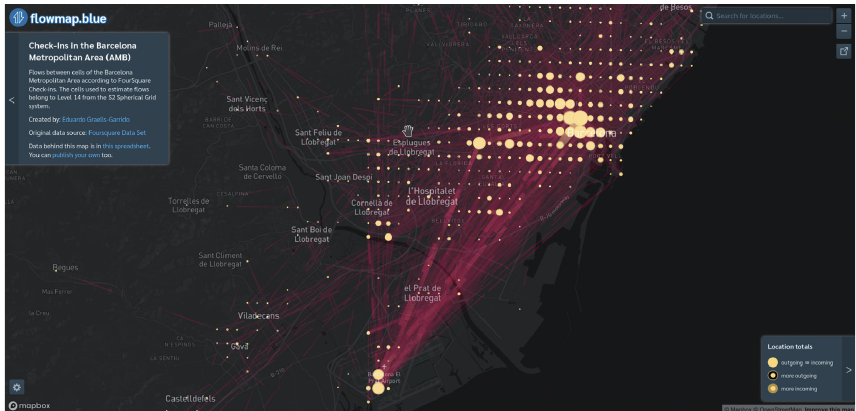
Figure 5: Network of visits for tourists and locals in Barcelona according to their check-ins.